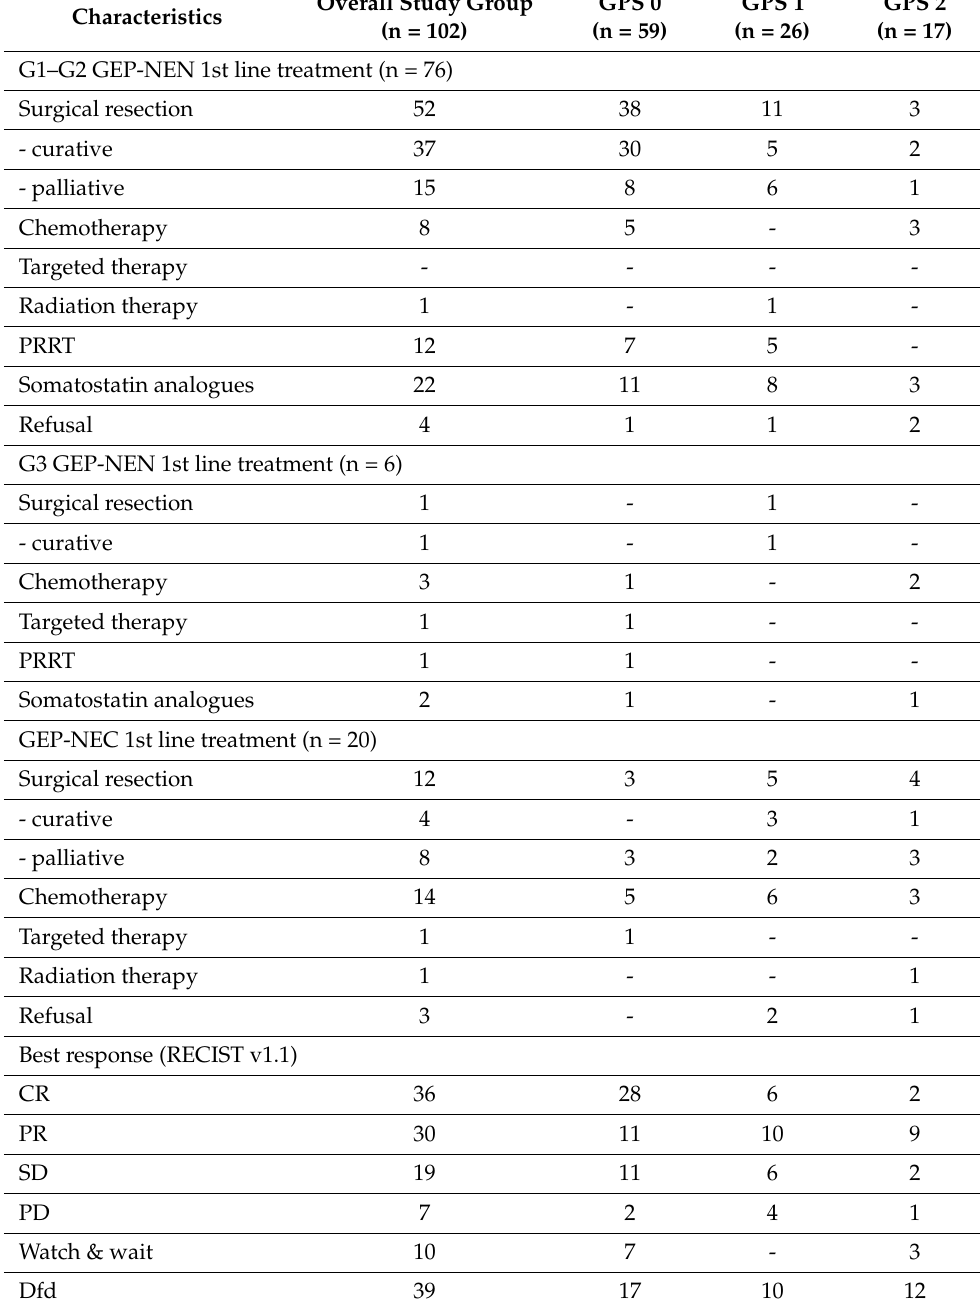
Table 6. First line treatment modalities of all GEP-NEN-patients included in the